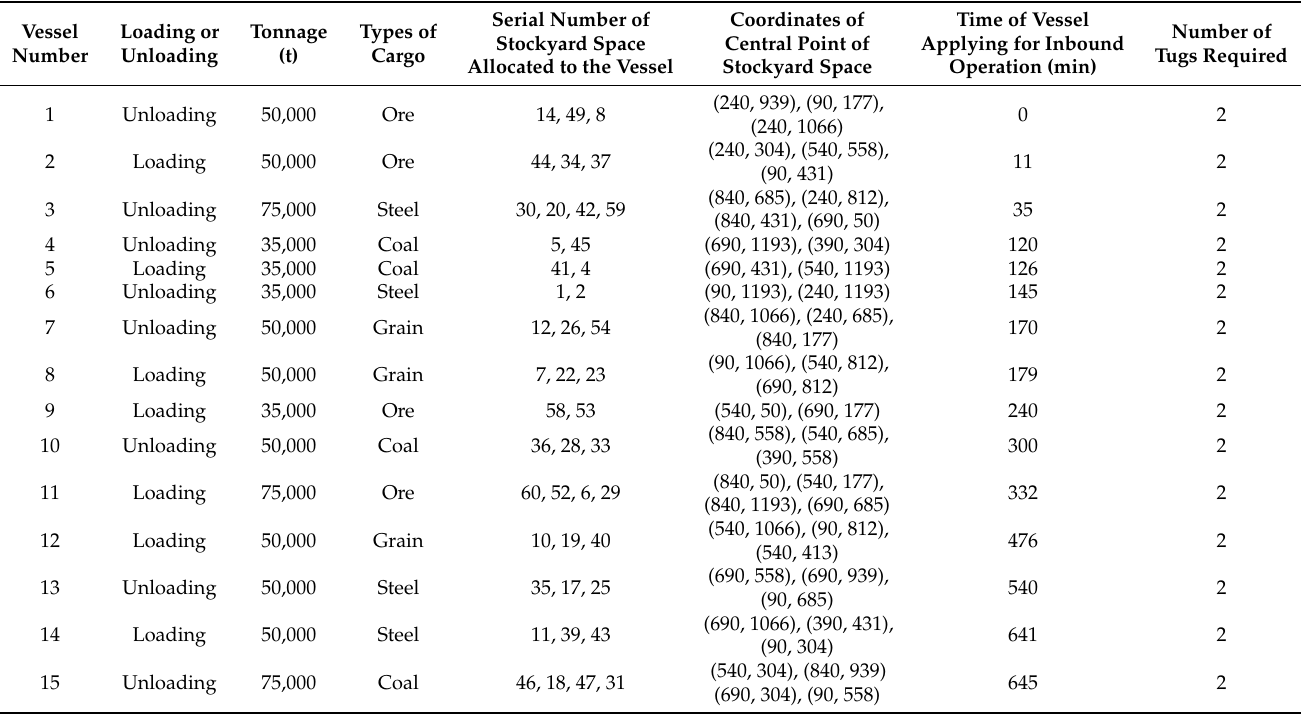
Table 5. Details of the 15 vessels used in the simulation.